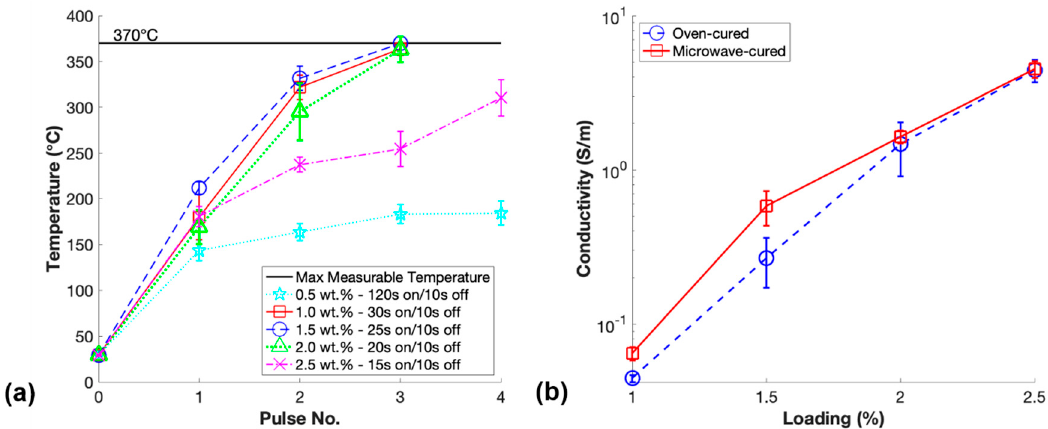
Figure 5. ( a ) Average temperature measurements between pulses of m-PDMS/CNT for each